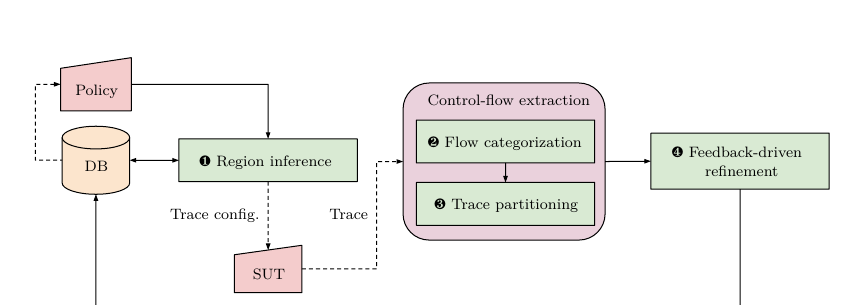
Figure 1: Overview of Incision . We indicate data-flow by block arrows for automatic propagation and dashed arrows for manual propagation. Incision operates in four step feedback loops. Region inference (step (cid:182) ) takes a policy and derives bounds to form a trace configuration. We use the bounds to take a trace of the SUT. From the trace, we perform control-flow extraction (steps (cid:183) and (cid:184) ) to identify task-switching logic and obtain analysis pass to propagate the newly added information (step (cid:185)